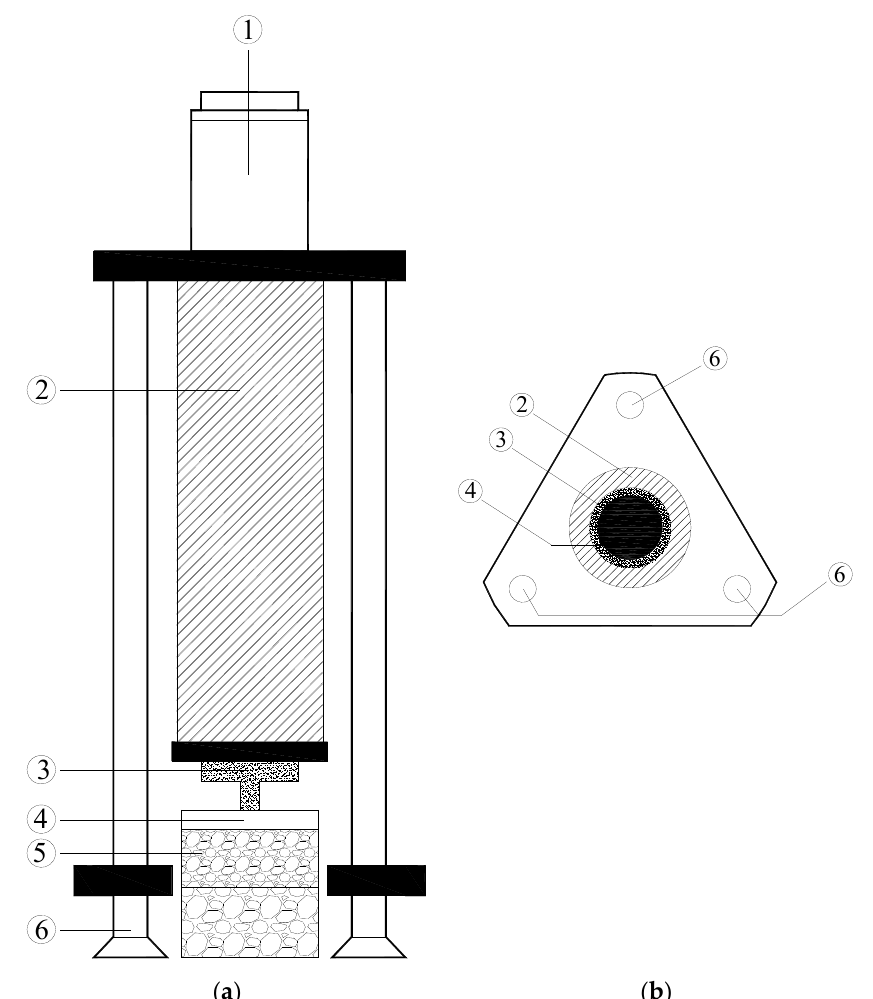
Figure 5. 1 (cid:79) motor 2 (cid:79) loading rod 3 (cid:79) load cell 4 (cid:79) top cap 5 (cid:79) test specimen 6 (cid:79) loading frame. Schematic Figure 5. Schematic diagram of the uniaxial tensile apparatus: ( a ) cross ‐ sectional view; ( b ) plane 208 diagram of the uniaxial tensile apparatus: ( a ) cross-sectional view; ( b ) plane